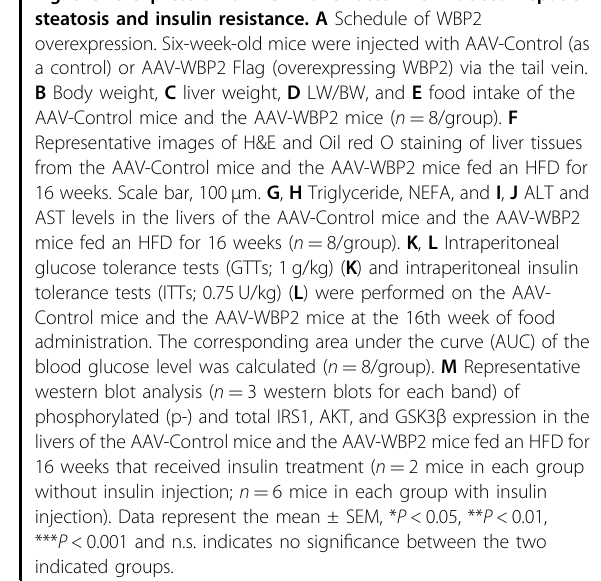
Fig. 3 Overexpression of WBP2 alleviates HFD-induced hepatic steatosis and insulin resistance. A Schedule of WBP2 overexpression. Six-week-old mice were injected with AAV-Control (as a control) or AAV-WBP2 Flag (overexpressing WBP2) via the tail vein. B Body weight, C liver weight, D LW/BW, and E food intake of the AAV-Control mice and the AAV-WBP2 mice ( n = 8/group). F Representative images of H&E and Oil red O staining of liver tissues from the AAV-Control mice and the AAV-WBP2 mice fed an HFD for 16 weeks. Scale bar, 100 μ m. G , H Triglyceride, NEFA, and I , J ALT and AST levels in the livers of the AAV-Control mice and the AAV-WBP2 mice fed an HFD for 16 weeks ( n = 8/group). K , L Intraperitoneal glucose tolerance tests (GTTs; 1 g/kg) ( K ) and intraperitoneal insulin tolerance tests (ITTs; 0.75 U/kg) ( L ) were performed on the AAV- Control mice and the AAV-WBP2 mice at the 16th week of food administration. The corresponding area under the curve (AUC) of the blood glucose level was calculated ( n = 8/group). M Representative western blot analysis ( n = 3 western blots for each band) of phosphorylated (p-) and total IRS1, AKT, and GSK3 β expression in the livers of the AAV-Control mice and the AAV-WBP2 mice fed an HFD for 16 weeks that received insulin treatment ( n = 2 mice in each group without insulin injection; n = 6 mice in each group with insulin injection). Data represent the mean ± SEM, * P < 0.05, ** P < 0.01, *** P < 0.001 and n.s. indicates no signi fi cance between the two indicated